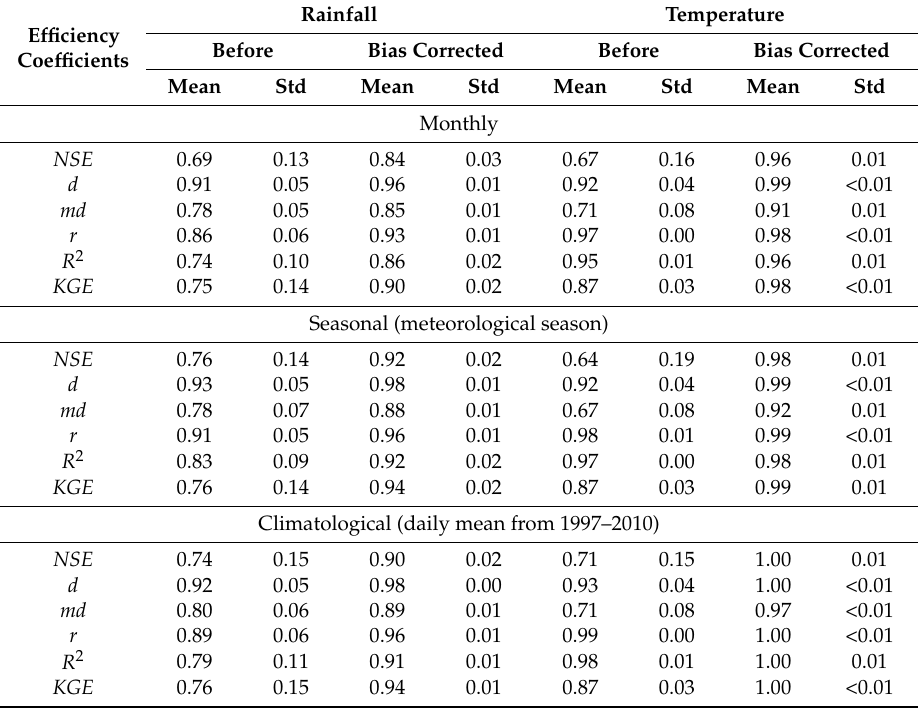
Table 2. Means and standard deviations of efficiency coefficients (8 GCMs) compared to observations before and after bias correction at monthly, seasonal (meteorological) and climatological time